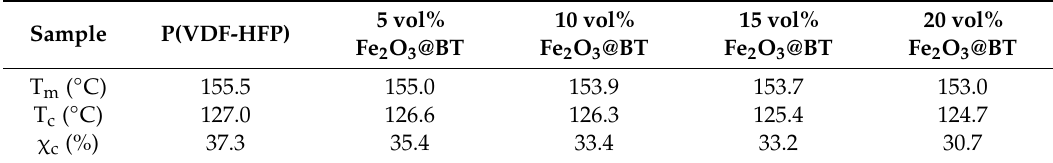
Table 1. Melting Temperature (T m ), crystallization temperature (T c ), and crystallinity ( χ c ) of polymer and FB/P(VDF-HFP) composites.